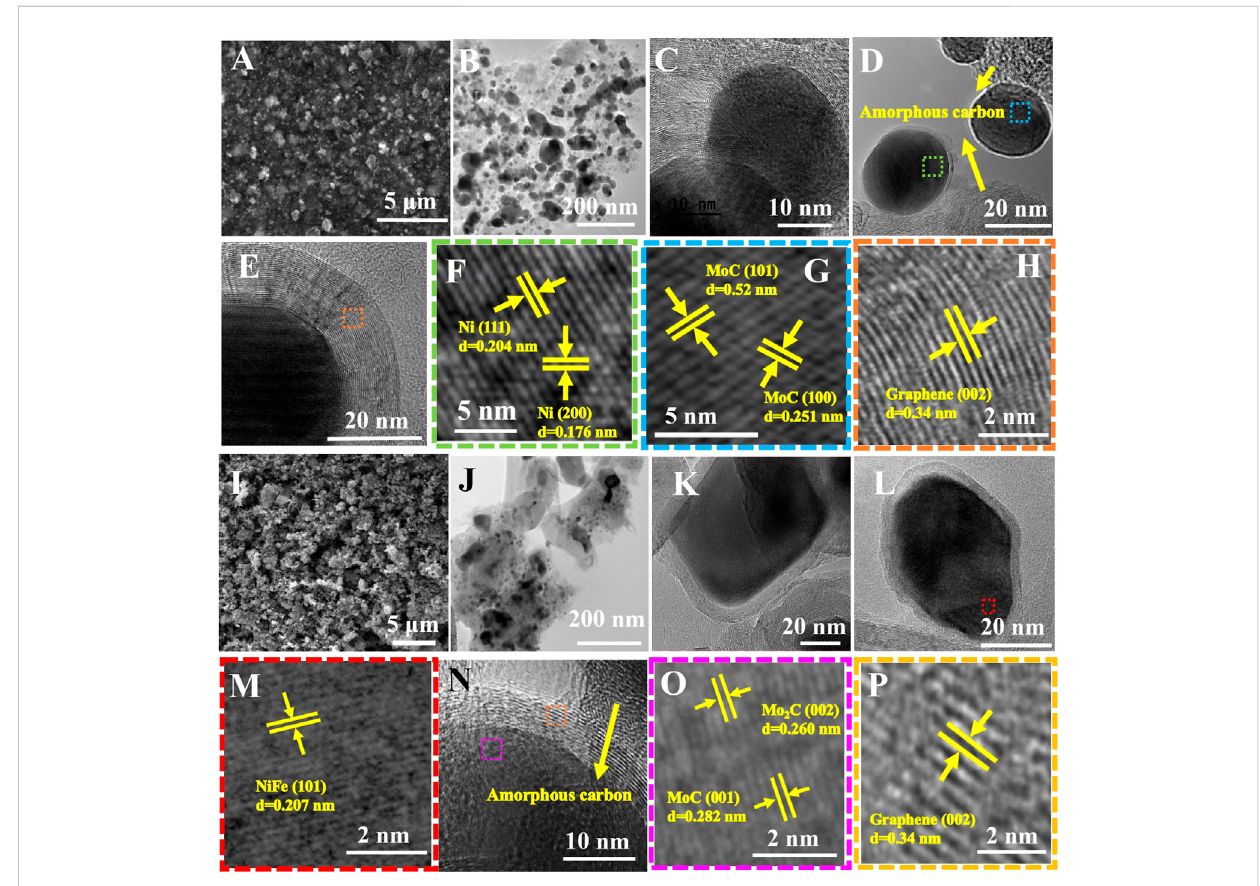
FIGURE 3 EM images of NiMoC@C (A – H) and NiFeMo 2 C@C (I – P) samples. (A, I) SEM images (B, J) low resolution TEM images. (C – H) HRTEM images of core- shell NiMoC@C samples. (F – G) HRTEM images of selected area in Figure 3D. (F) from area highlighted in green in Figure 3D. (G) from area highlighted in blueinFigure3D. (H) HRTEMimageofhighlightedarea(inorange)fromFigure3E. (K – P) HRTEMimagesofcore-shellNiFeMo 2 C@C. (M) HRTEMimageof selected area in Figure 3L, from area highlighted in red. (O) HRTEM image of selected area in Figure 3N: from area highlighted in pink. (P) HRTEM image of selected area in Figure 3N: from area highlighted in